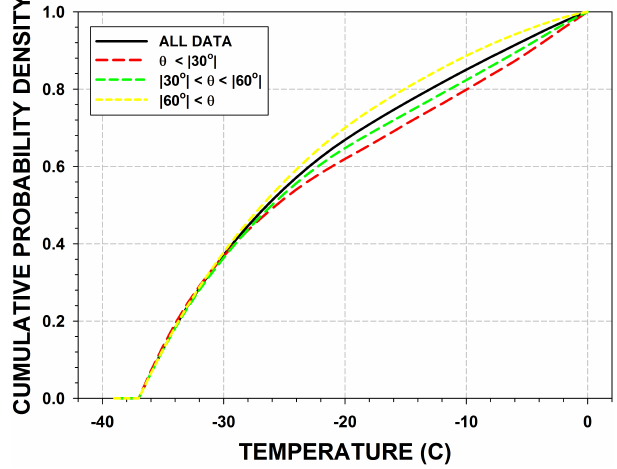
Figure 3. (a) Total global sample counts as a function of top height temperature for all clouds identified as ice phase from 2012 CALIOP V3.02 L2_CPro-5km data set, including overlay of − 37 ◦ C isotherm, and subset sample counts for (b) the tropics ( θ ≤ | 30 ◦ | ), (c) midlatitudes ( | 30 ◦ | < θ ≤ | 60 ◦ | ) and (d) polar re- gions ( θ > | 60 ◦ | ). The abrupt cutoff at − 73 ◦ C in (d) is an artifact of the screening process imposed to eliminate polar stratospheric clouds.